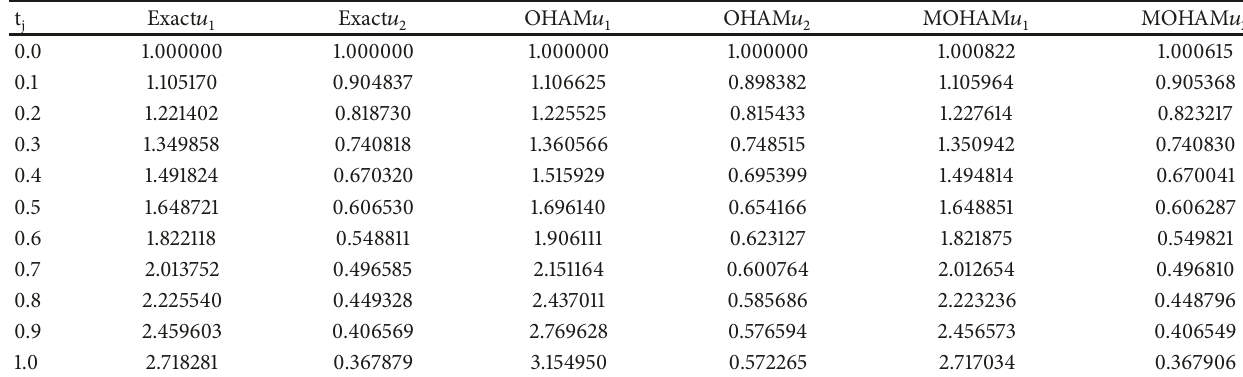
Table 2: The results of applying OHAM, MOHAM, and the exact solution, for Example 1.